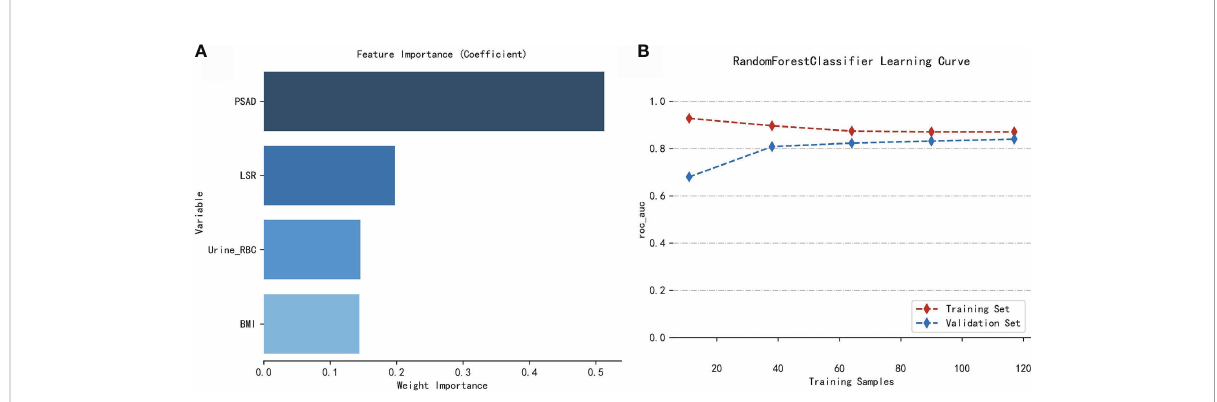
FIGURE 4 Analysis of the RF model. (A) Importance of the variables included in the RF model in the training cohort. (B) Learning curves of the RF model in the training